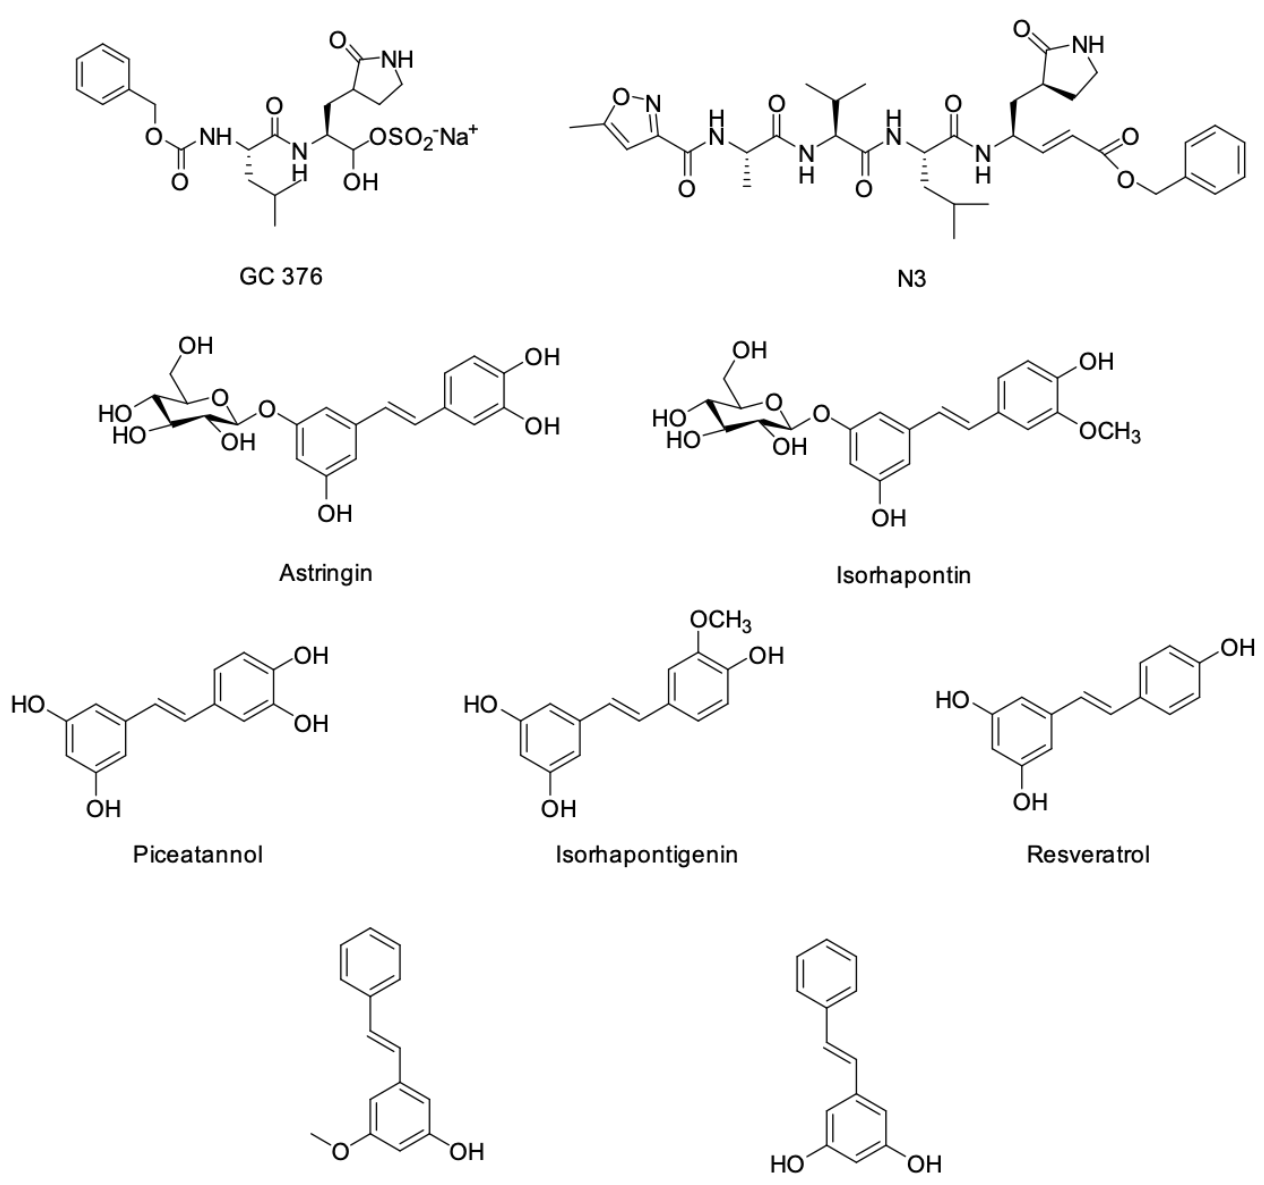
4 Table 1. Reference and stilbene compounds used for the molecular docking studies against M pro . Ligand